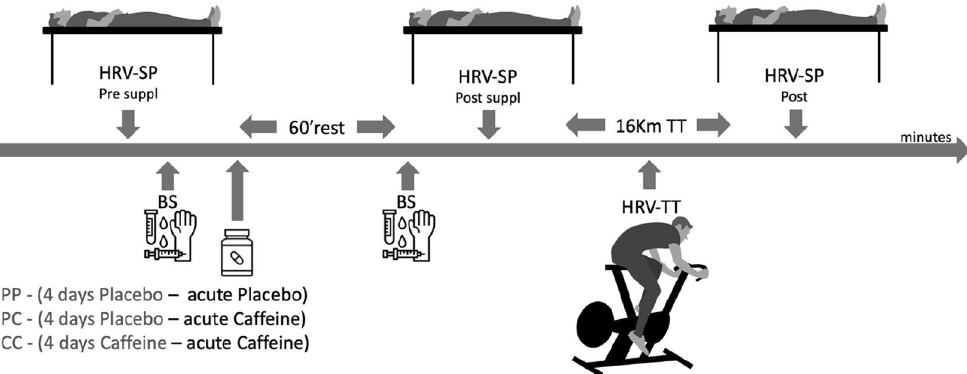
Figure 4. Dynamics of data acquisition. Placebo–Placebo (PP), Placebo–Caffeine (PC) and Caffeine–Caffeine (CC) conditions were tested in 16 km time Trial (16 km TT) performance and HRV analysis were done pre supplementation (HRV-SP PRE suppl), post supplementation (HRV-SP POST suppl) during 16 km TT (HRV-TT) and post 16 km TT (HRV-SP